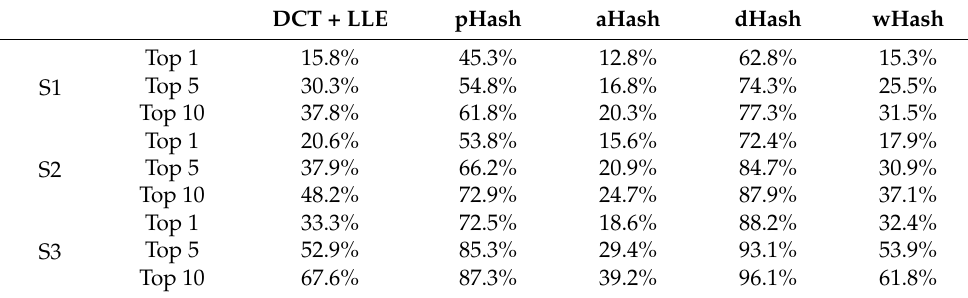
Table A4. Correct matches results for Database vs TS2 comparison—with Radon transform or without contrast stretching application (256-bit).